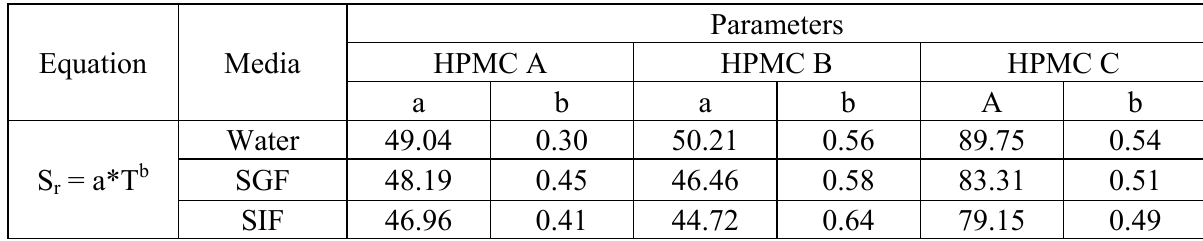
Table 9. Power law parameters simulating swelling of